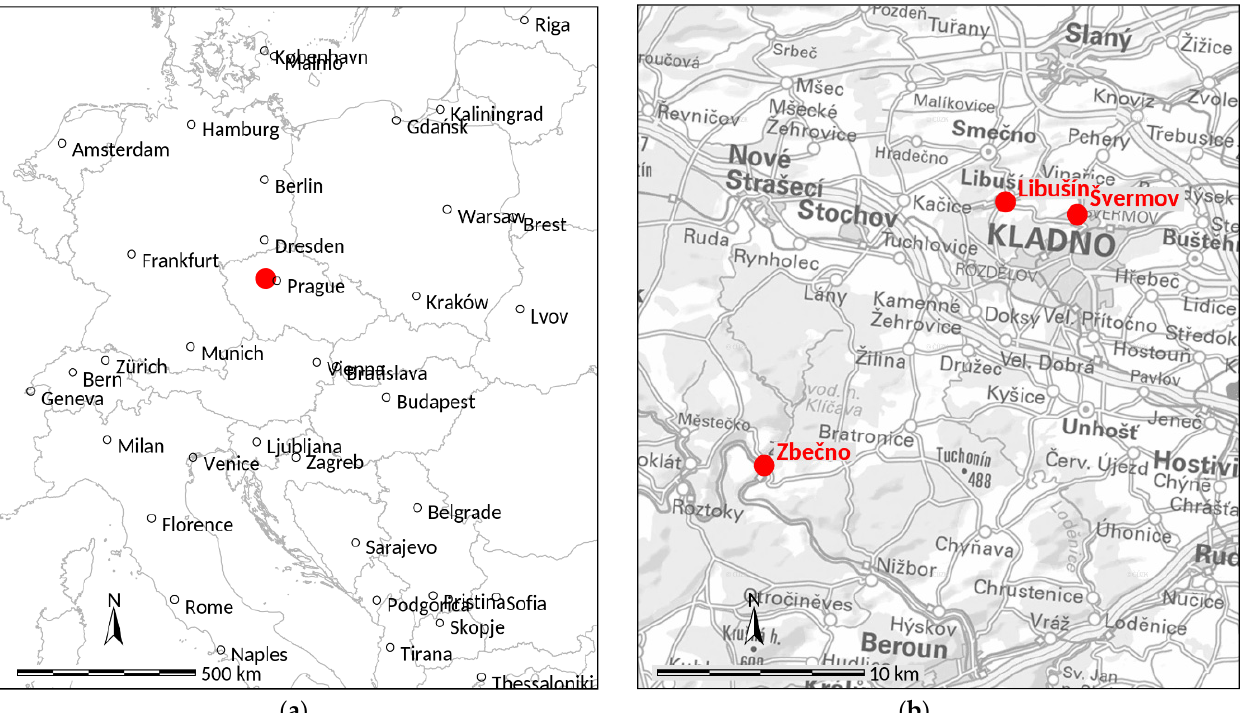
Figure 1. The location of the area of interest: ( a ) Position within Central Europe; ( b ) Sampling site locations. Topography base: ( a ) Made with Natural Earth. Free vector and raster map data at naturalearthdata.com; ( b ) Č ÚZK, State Administration of Land Surveying and Cadastre.